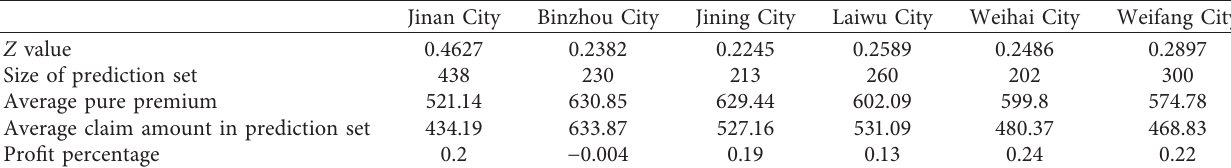
Table 2: The comparison between the predicted pure premium and actual total claim.